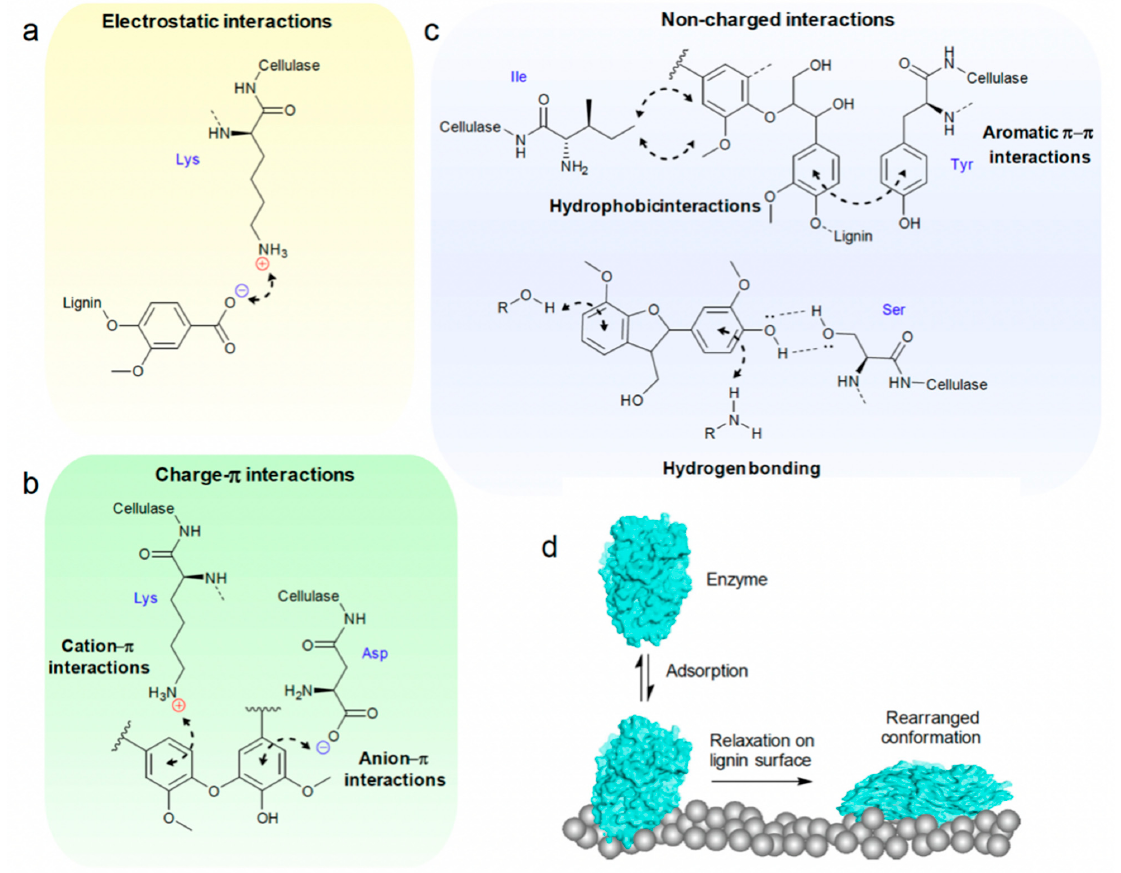
Figure 5. The main interactions between cellulose enzyme and lignin ( a – c ) that lead to the adsorption, structural rearrangements, and irreversible binding of enzymes on the surface of lignin ( d ) [57].